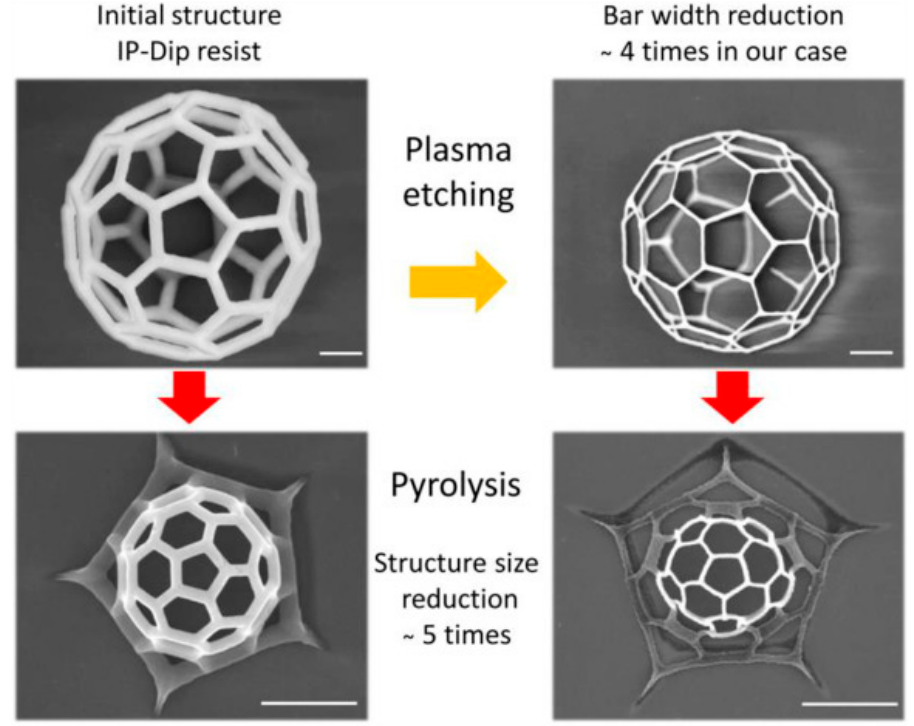
Figure 10. Illustration of reduction in feature size by separate use of oxygen plasma etching, pyrolysis and then a combination of the two techniques [87].